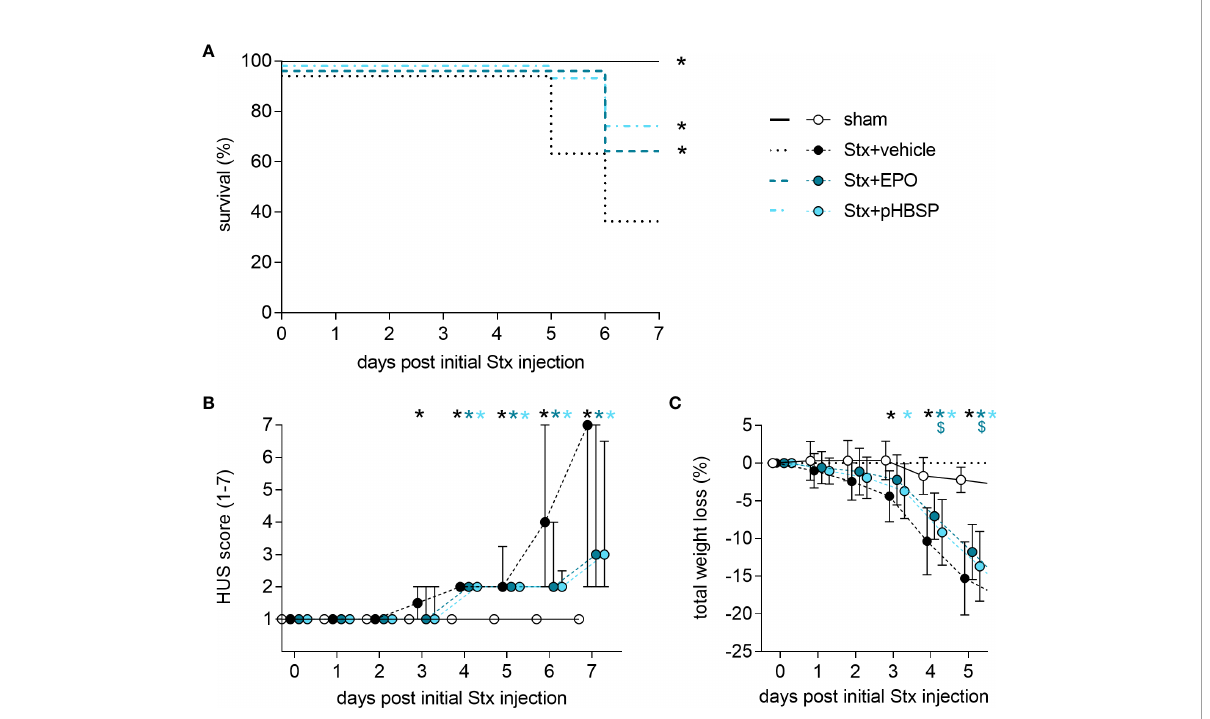
FIGURE 3 Effect of EPO and pHBSP treatment on survival and clinical presentation of mice with HUS. (A-C) Mice received either Stx or vehicle intravenously to induce experimental HUS. Mice with HUS were treated with vehicle (Ringer ’ s solution 1 h post HUS induction s.c.), EPO (1 h post HUS induction s.c., 1000 IU/kg BW once) or pHBSP (1 h post HUS induction s.c., 30 µg/kg BW every 24 h; sham n = 15, Stx+vehicle n = 26, Stx+EPO n = 22, Stx+pHBSP n = 21). (A) Kaplan-Meier 7-day survival curves of sham mice, Stx-challenged mice treated with vehicle,